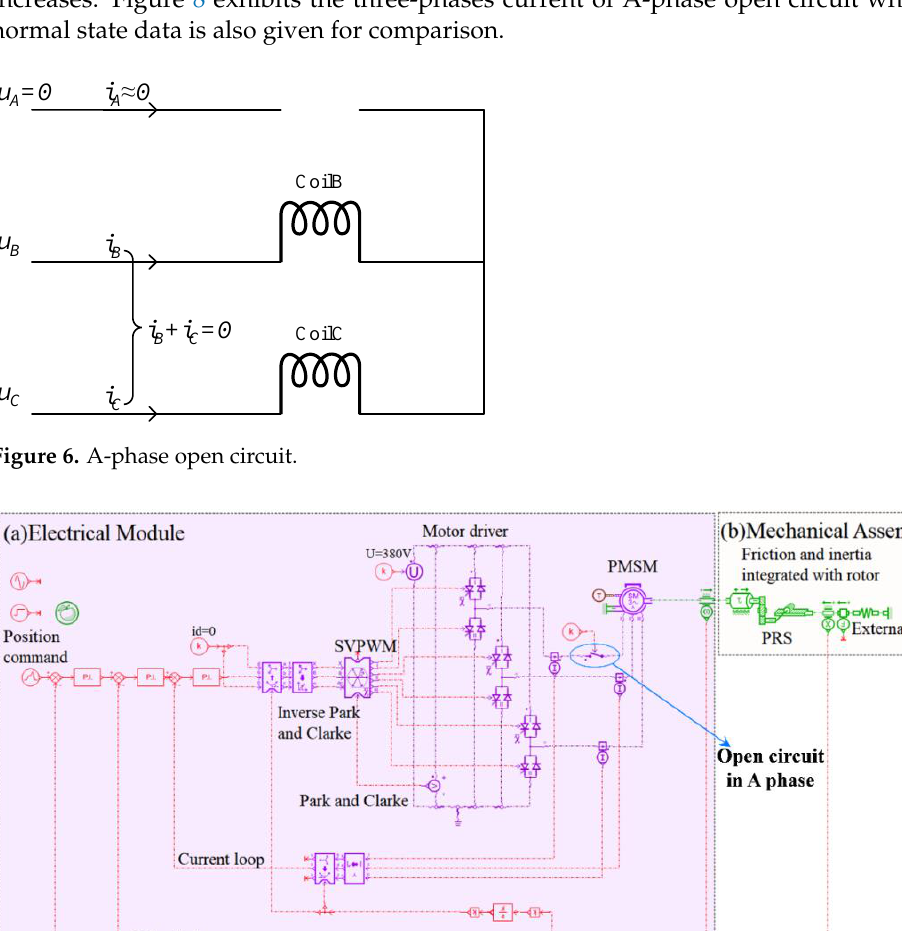
Figure 7. Open circuit fault injection. ( a ) Electrical Module. ( b ) Mechanical Assembly.